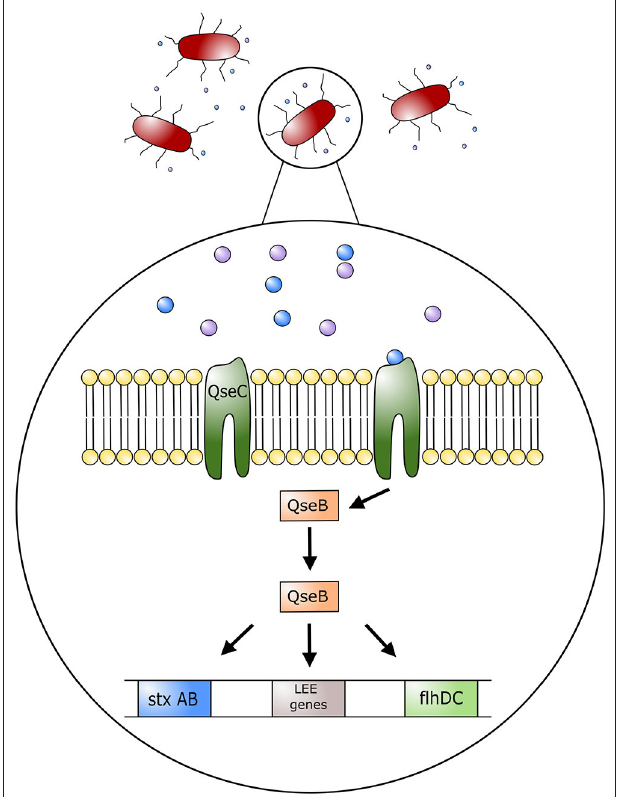
FIGURE 3 | Model of regulation of Escherichia coli O157:H7 pathogenic genes by AI-3, epinephrine and norepinephrine. Quorum sensing molecule AI-3, and host stress hormones epinephrine and norepinephrine bind to the bacterium membrane receptor (QseC); this in turn triggers the phosphorylation of the response regulator QseB, which stimulates the expression of the locus of enterocyte effacement (LEE) genes, motility genes (flhDC), and Shiga toxin (StxAB). LEE genes will encode for the type three secretion system (TTSS) and promote attaching effacing lesions on host cell membranes.